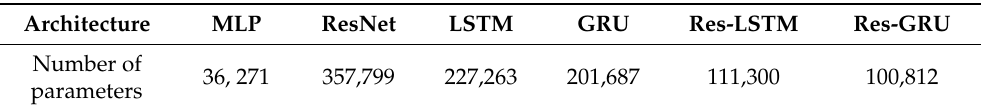
Table 2. Number of parameters of the six ML